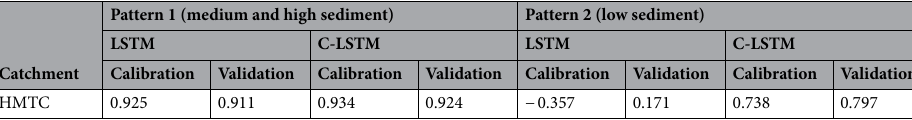
Table 3. NSE evaluation of simulation results of two